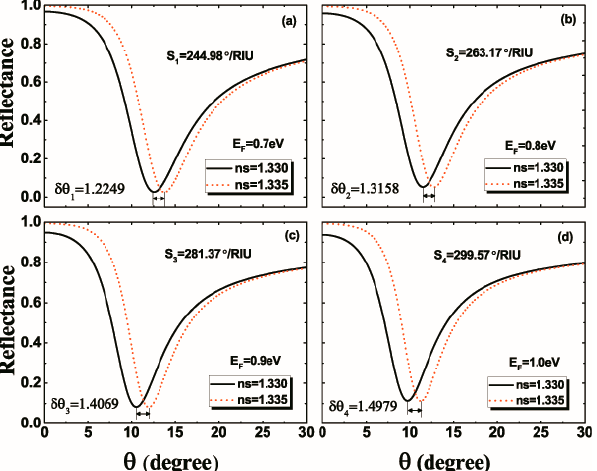
Figure 4. Variations of reflectance with respect to the incident angle under ( a ) E F = 0.7eV, ( b ) E F = 0.8eV, ( c ) E F = 0.9eV, ( d ) E F = 1.0eV. The relaxation time and number of graphene layers are set as τ = 0.5 ps and L = 1, respectively. The sensing medium is set as d s = 390 µ